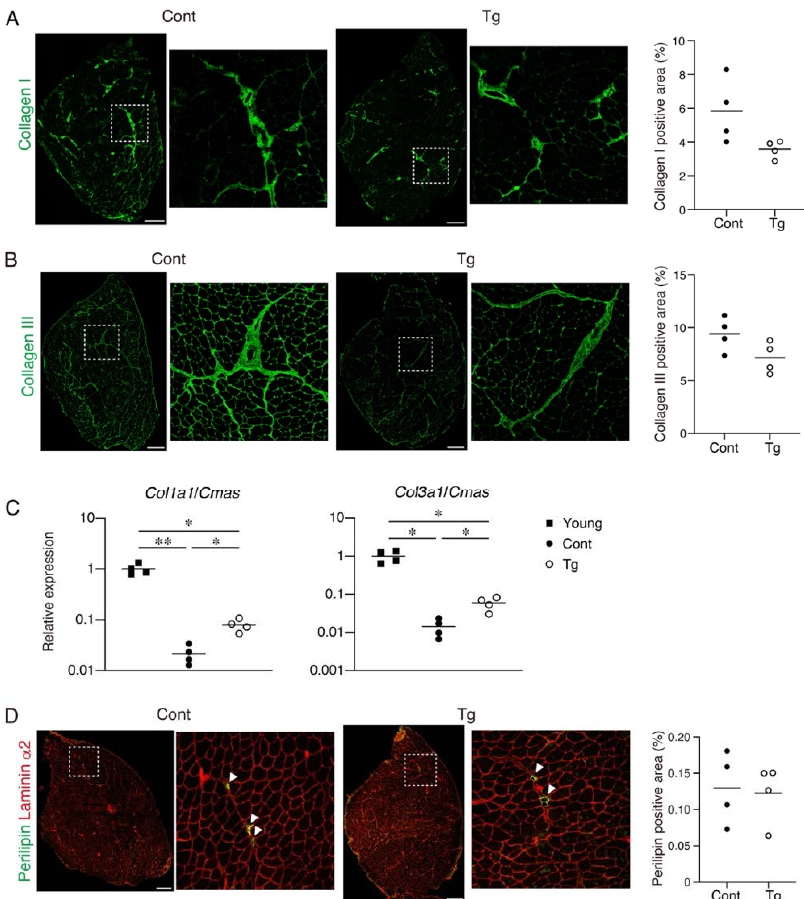
Figure 3. The extent of the fibrosis and fat infiltration in the skeletal muscle. ( A ) Tibialis anterior (TA) muscle sections of the Tg mice and littermate control mice (Cont, WT / CAG-CAT-Bmp3b ) were stained with an antibody against collagen I (green). The right panels are magnified views of the boxed regions in the left panels. The percentage of the collagen I + area is shown. ( B ) The TA muscle sections of the Tg mice and littermate control mice (Cont, WT / CAG-CAT-Bmp3b ) were stained with an antibody against collagen III (green). The right panels are magnified views of the boxed regions in the left panels. The percentage of the collagen III + area is shown. ( C ) The gene expression levels of Col1a1 and Col3a1 in the young, geriatric control (Cont, WT / CAG-CAT-Bmp3b ) and the geriatric Tg mice are shown. ( D ) The TA muscle sections of the Tg mice and littermate control mice (Cont, WT / CAG-CAT-Bmp3b ) were stained with antibodies against perilipin (green) and laminin α2 (red). The right panels are magnified views of the boxed regions in the left panels. The arrowheads indicate perilipin + ectopic adipocytes located in the interstitial space. The percentage of the perilipin + area is shown. The data are expressed as the means and individual data points; two-sided unpaired t -test ( A , B , D ). Brown–Forsythe and Welch ANOVA test ( C ). n = 4 mice. * p < 0.05 and ** p < 0.01. Scale bar: 300 µm.